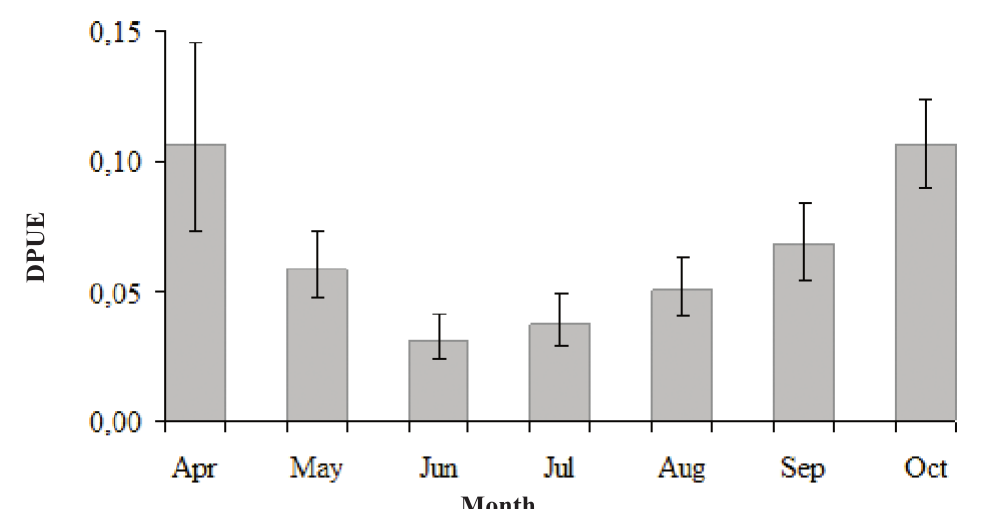
Fig. 3. Damaged fish bags per unit effort, DPUE (number of damaged fish bags • (total num- ber of fish bags • number of days) -1 ), in the Kattegat-Skagerrak eel fishery with fyke nets on a monthly basis 1999-2004. The fyke nets were checked 2065 times, by seven different fisher- men. Error bars indicate 95% confidence interval. Data from Königson et al.